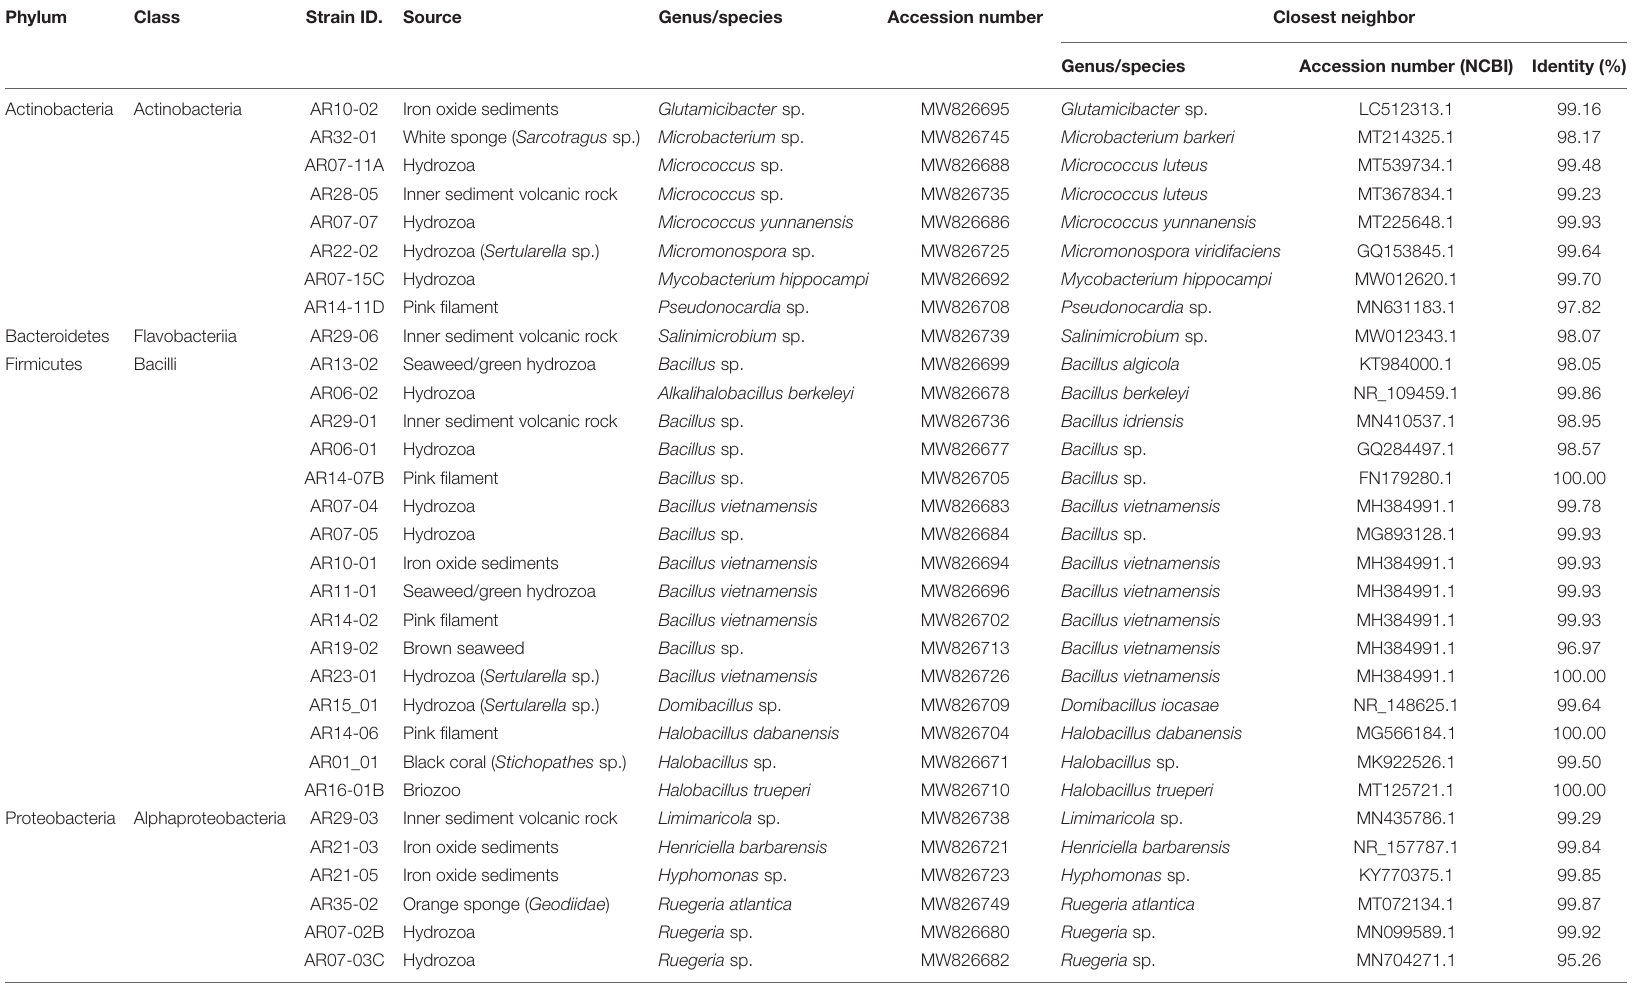
TABLE 1 | Summary of the bacterial isolates and phylogenetically closely related species from GenBank according to 16S rRNA gene sequence similarity.